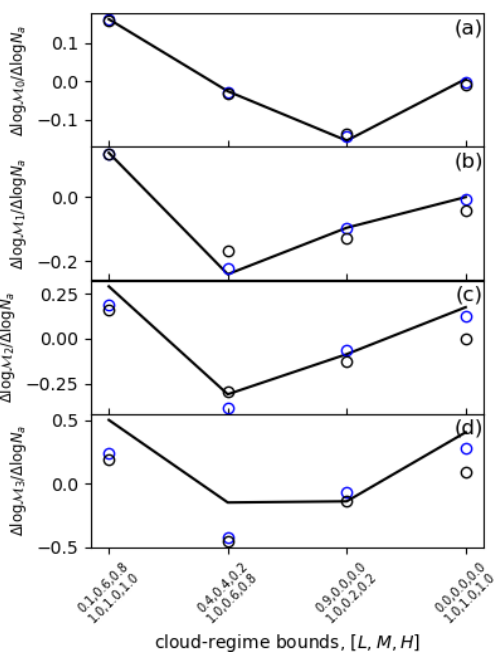
Figure 9. The sensitivities of bulk rainfall characteristics to aerosol perturbations for each cloud-fraction regime (horizontal axis). (a) The sensitivity of mean rainfall frequency, (b) the sensitivity of mean rainfall amount and (c, d) the sensitivities of the second and third moments of the rainfall rate distribution. The blue and black circles show the sensitivities predicted by the double- and single- moment closures,